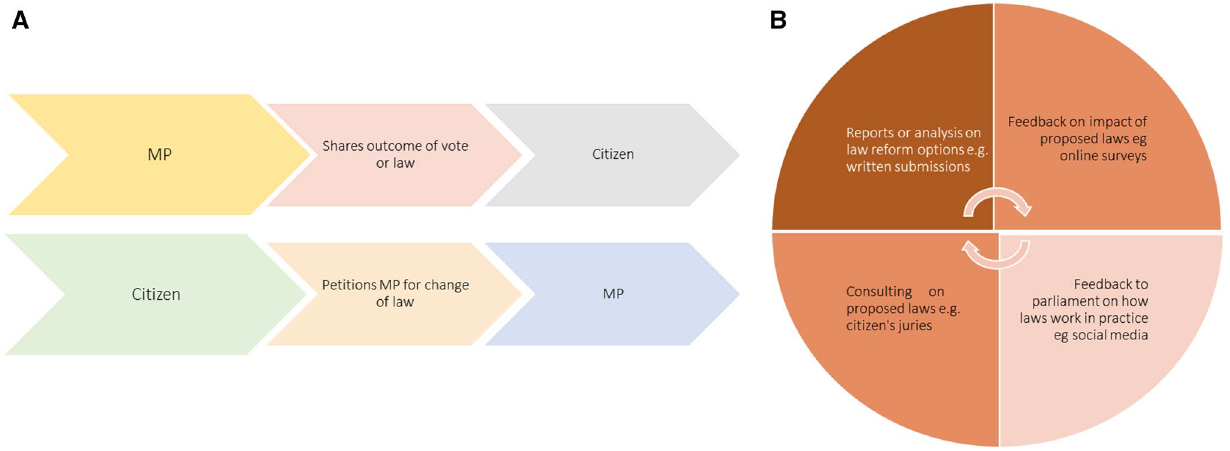
Fig. 1 Types of public engagement. Public engagement as two types of one-way information sharing ( A ) and as a deliberative process ( B